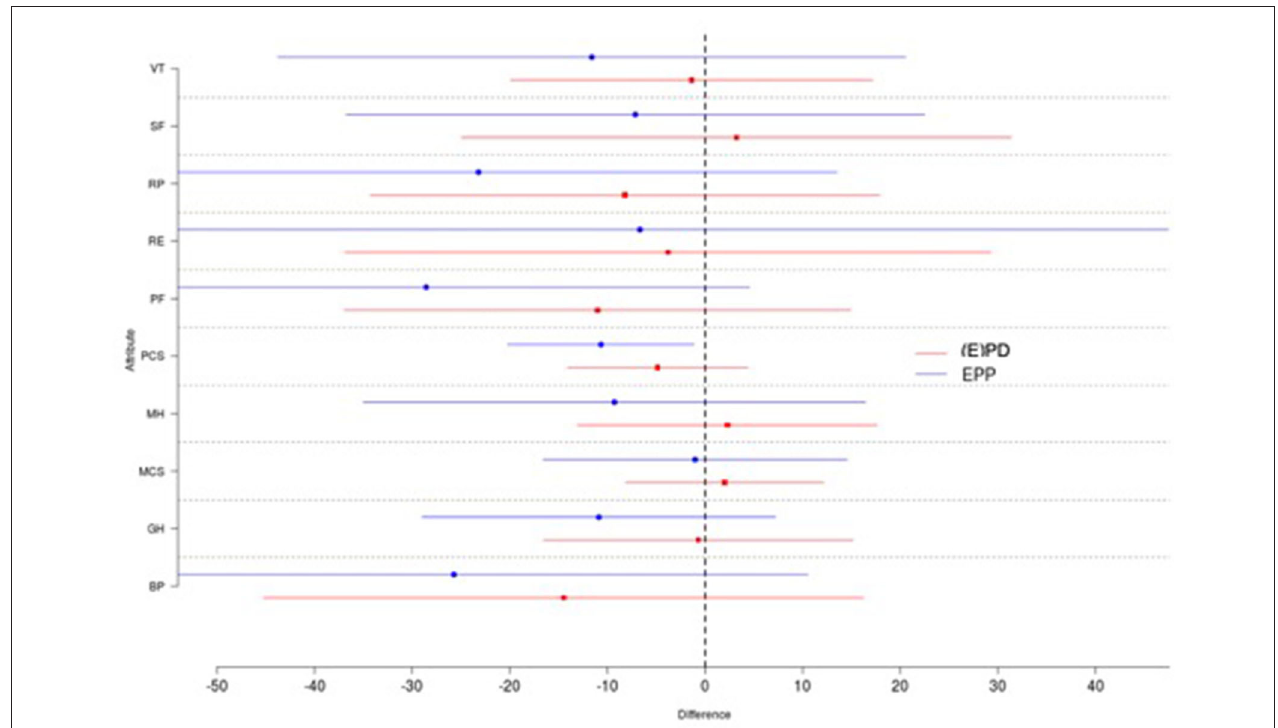
FIGURE 5 | Shown are the means and standard deviations for each group and each attribute. One does not observe significant differences between the (E)PD (red) and EPP (blue) patients. There exists a trend toward a higher quality of life for the (E)PD treatment group as every single difference in the (E)PD group is further to the right compared to the EPP group. VT, vitality; SF, social functioning; RP, role physician; RE, role emotional; PF, physical functioning; PCS, physical component status; MH, mental health; MCS, mental component status; GH, global health; BP, bodily pain.